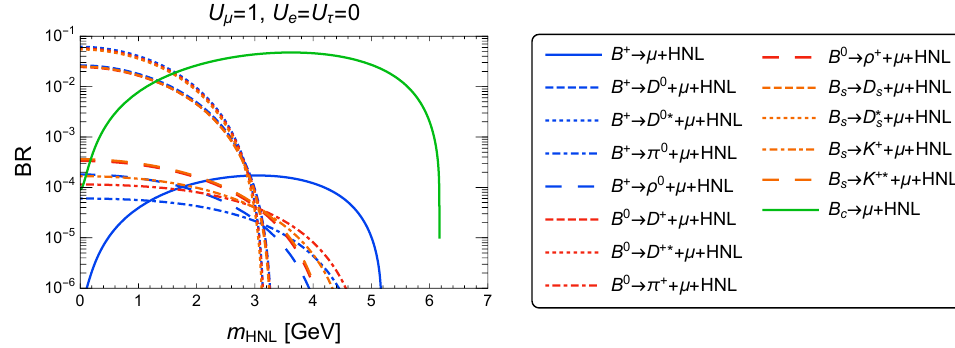
Figure 18 . The same plot as figure 15 but for U µ = 1 , U e = U τ = 0 .